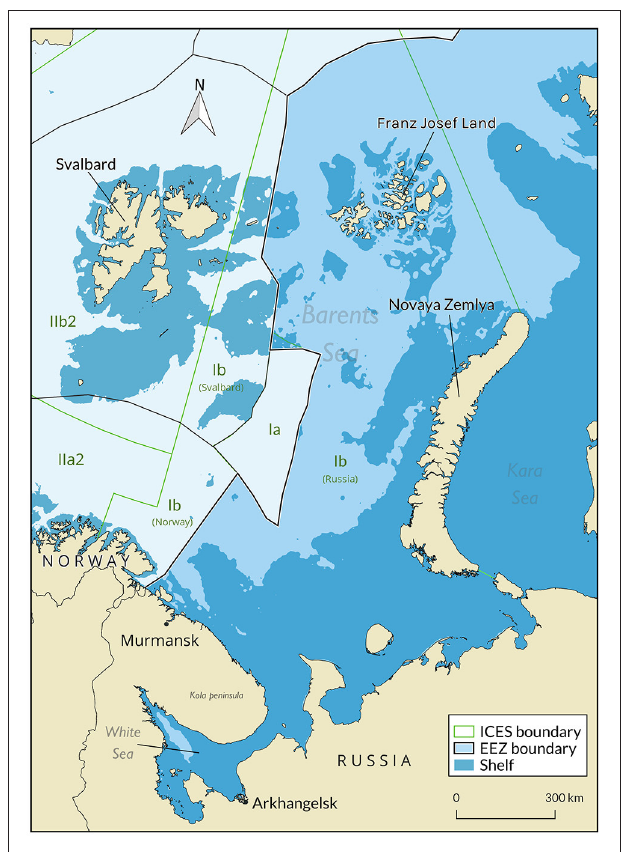
FIGURE 1 | Map of the Barents Sea region, including the Exclusive Economic Zones (EEZ) and shelf areas (to 200m depth) of the Russian Federation and neighboring Norway. ICES statistical areas fall within the green boundaries. We define the Barents Sea here as corresponding to ICES areas Ia and Ib. The White Sea falls between the Kola peninsula and